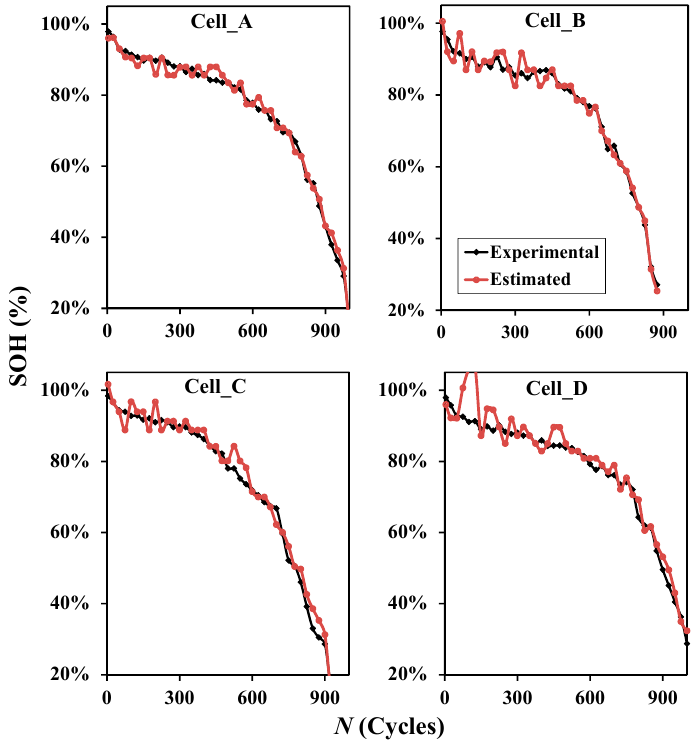
Figure 7. Estimated and experimental SOHs of cells A-D using cell A for model construction.